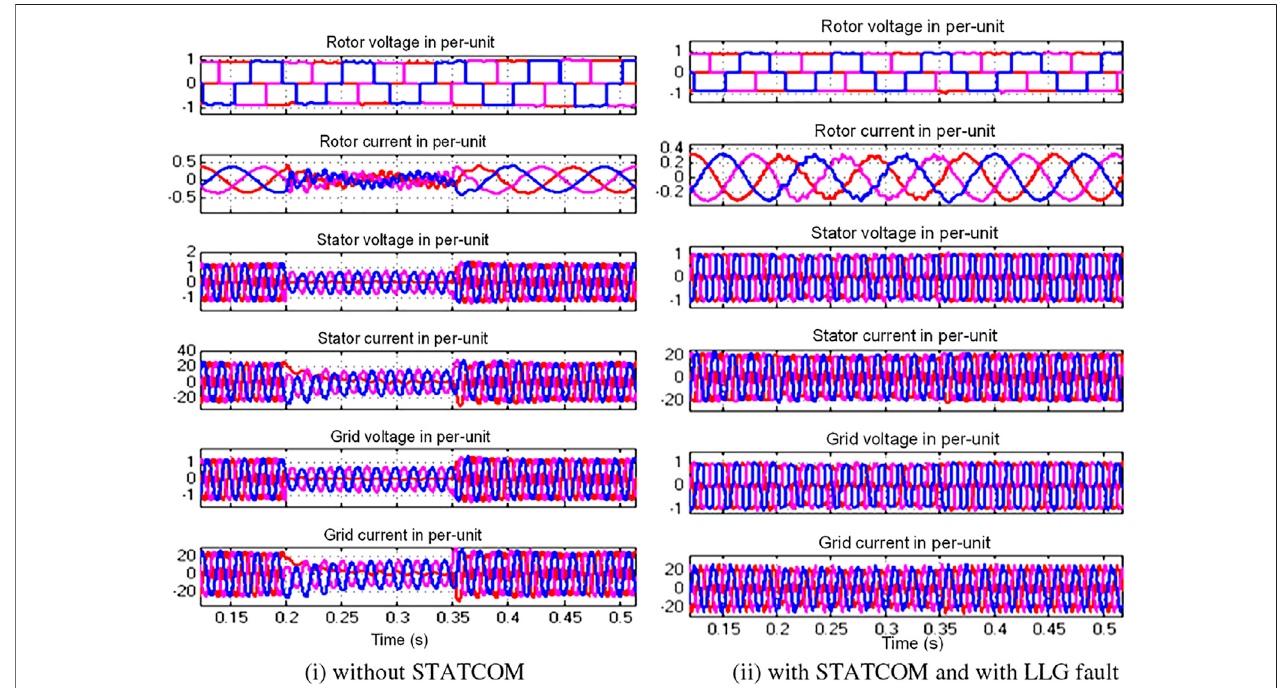
FIGURE 7 | DFIG parameters computed in conventional and proposed cases. (i) Without STATCOM. (ii) With STATCOM and with LLG fault.